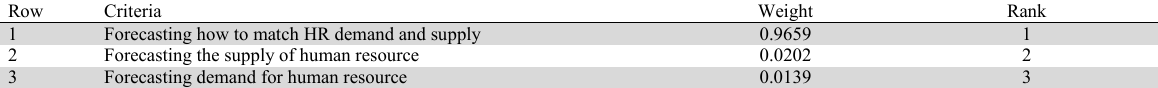
Ranking of human resource planning